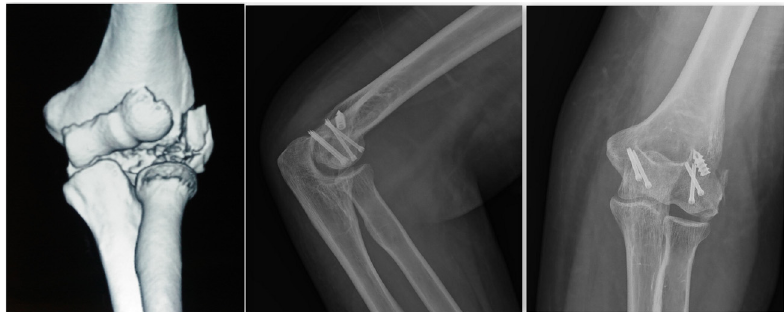
Figure 7. LCL avulsion fracture and fi xation of LCL with suture